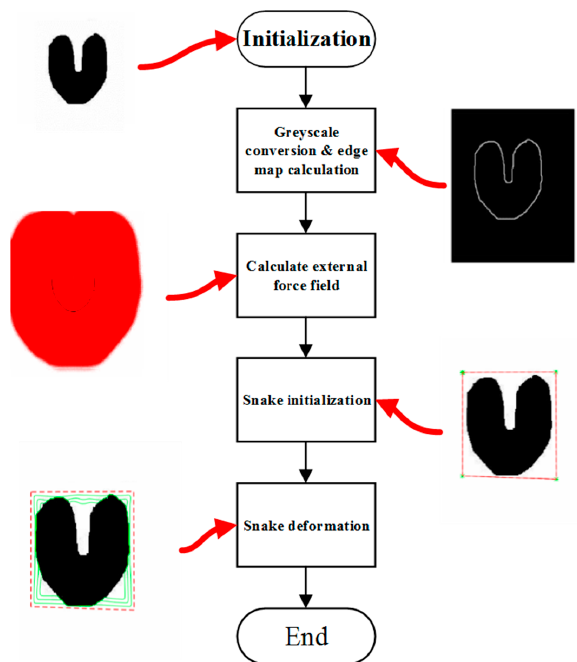
Figure 3. The flowchart of the algorithm.